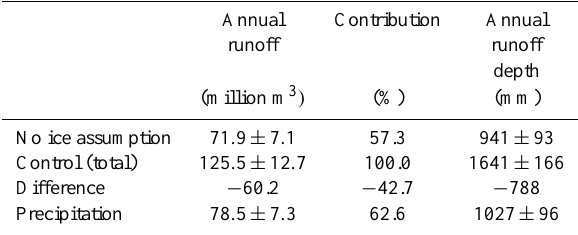
Table 5. Annual runoff and runoff depth associated with the pres- ence of ice in the Tsho Rolpa Glacial Lake–Trambau Glacier basin. Errors represent interannual variability calculated for the period 1979–2007 (28 years).